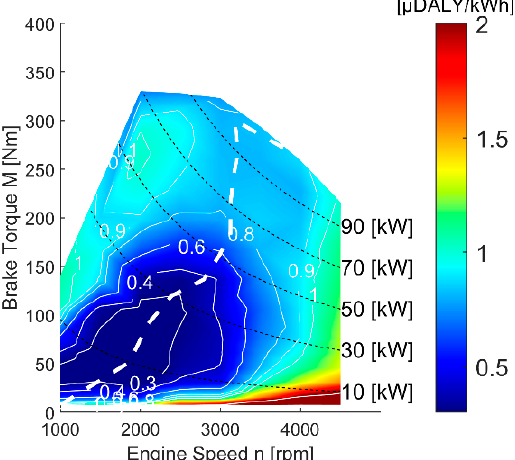
Figure 5. Iso-level curve of the total damage and curve of the minimum total damage (white dotted line).